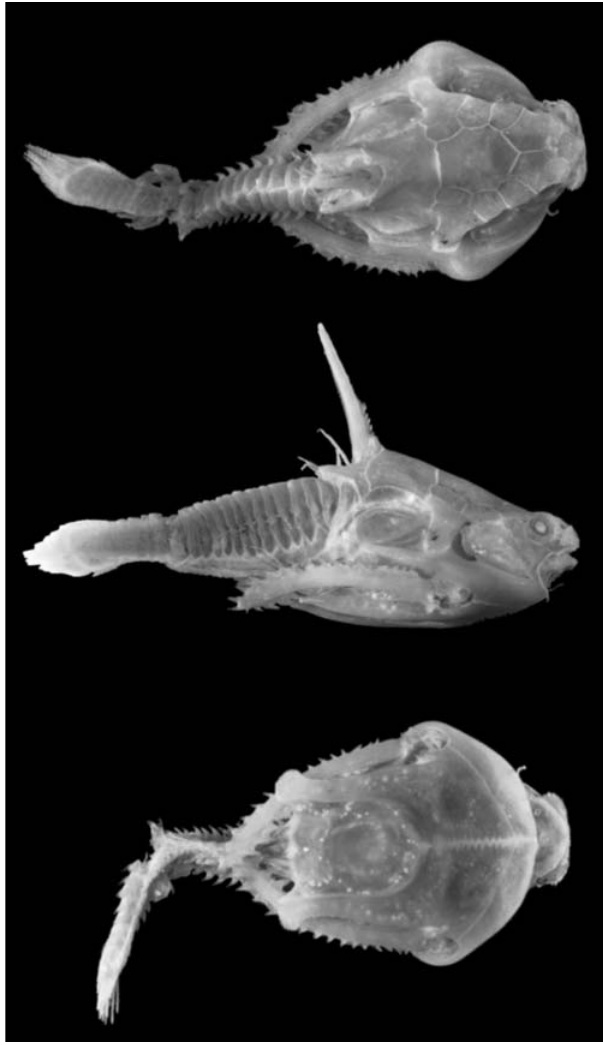
Fig. 3. Physopyxis lyra Cope, 1871, holotype. ANSP 8282 (35.0 mm TL), río Ampyiacu, Peru. Photo by Mark